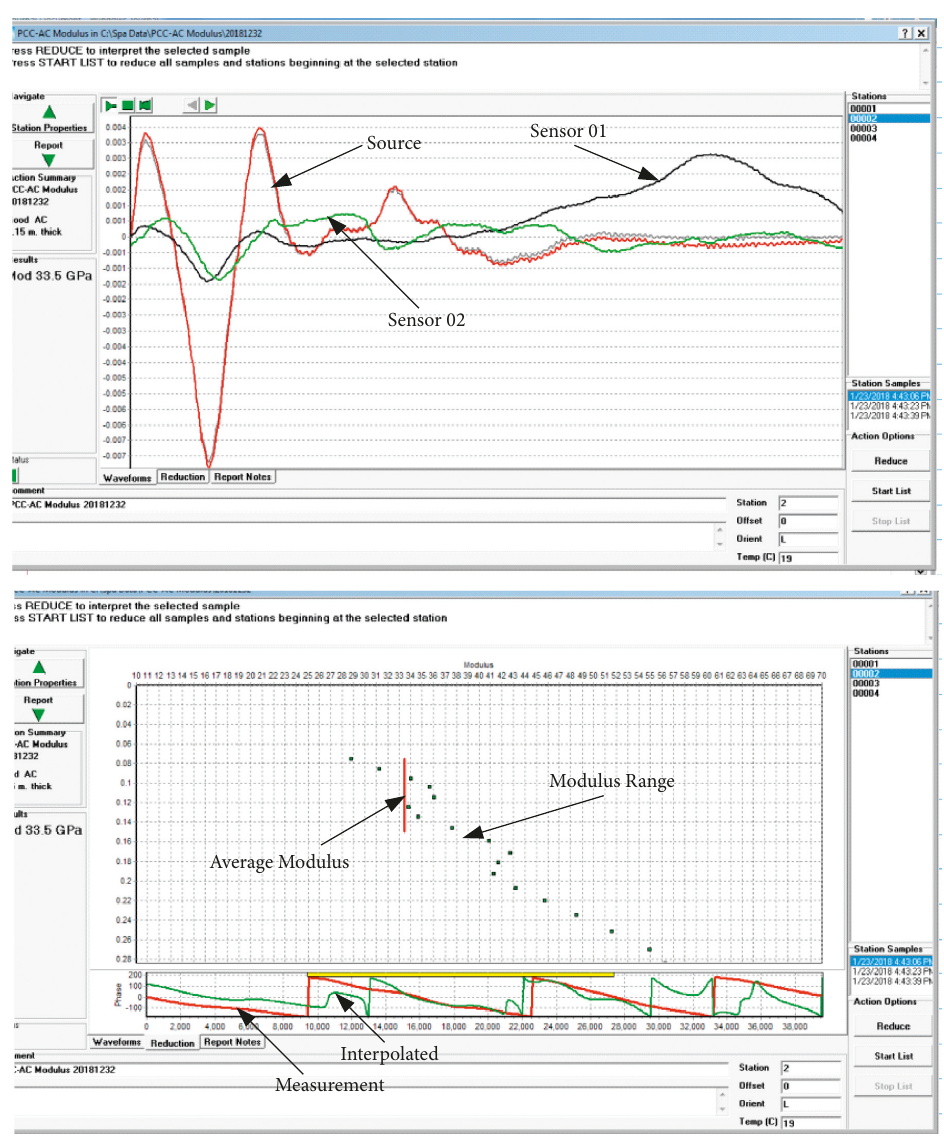
Figure 12: PSPA time records and dispersion